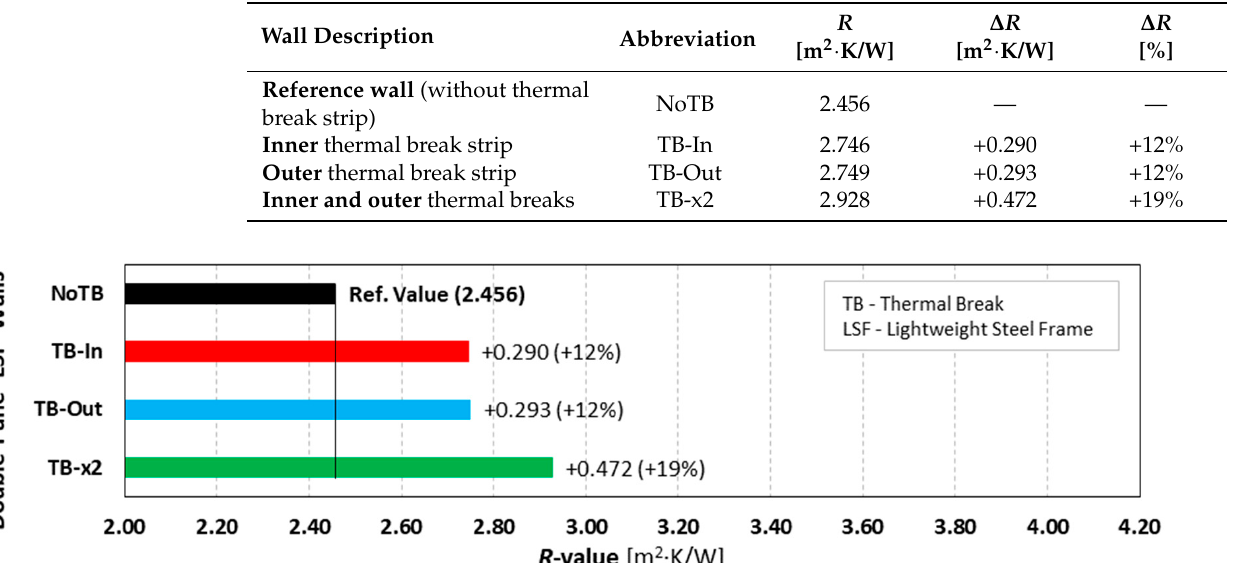
Figure 6. Measured thermal resistance improvement due to aerogel thermal break strips.